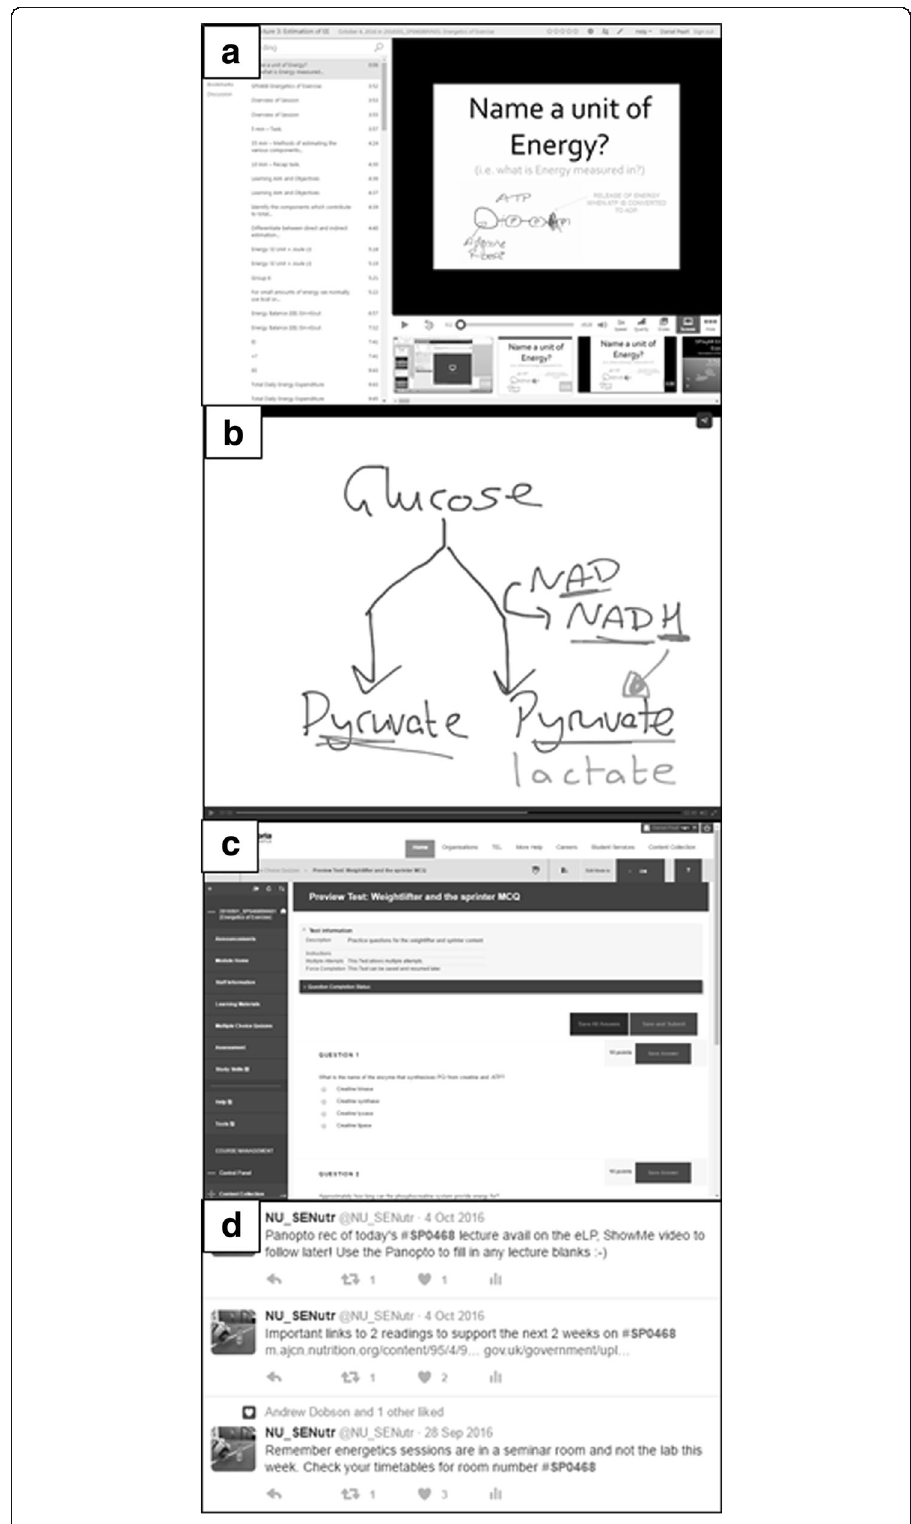
Fig. 1 Screenshots of Panopto ( a ), ShowMe ( b ), MCQ ( c ) and Twitter ( d